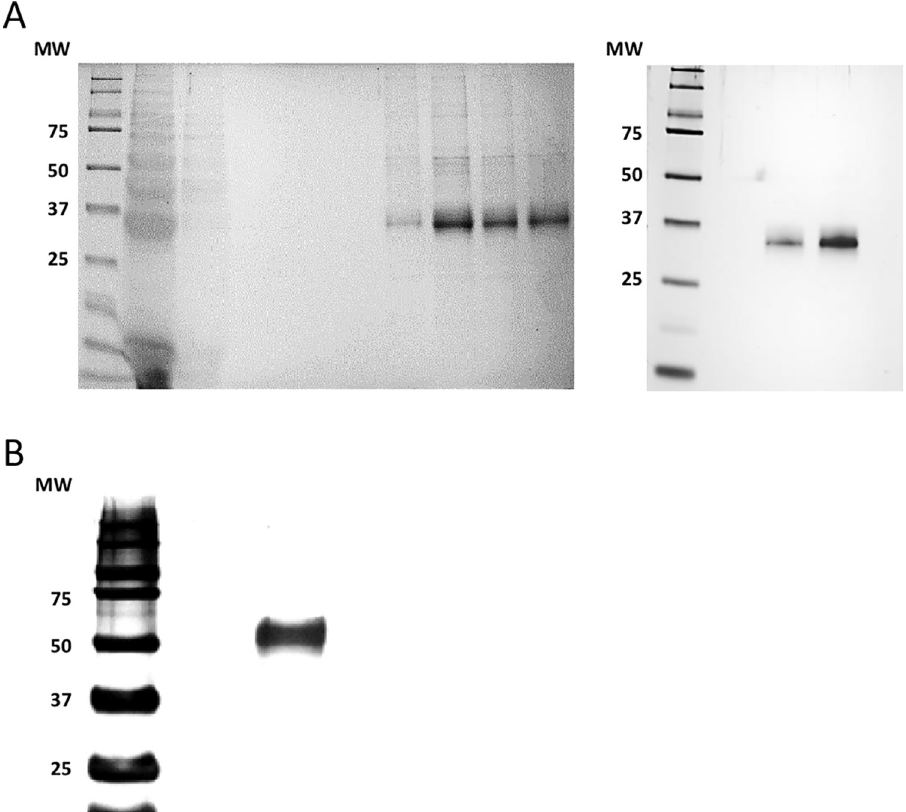
Fig 1. A : Representative Coomassie gel electrophoresis (left panel) and silver stain (right panel) of SARS-CoV2 wild type spike RBD protein (A) and of nucleocapsid protein (B). https://doi.org/10.1371/journal.pone.0266701.g001 PLOS ONE | https://doi.org/10.1371/journal.pone.0266701 April 25,